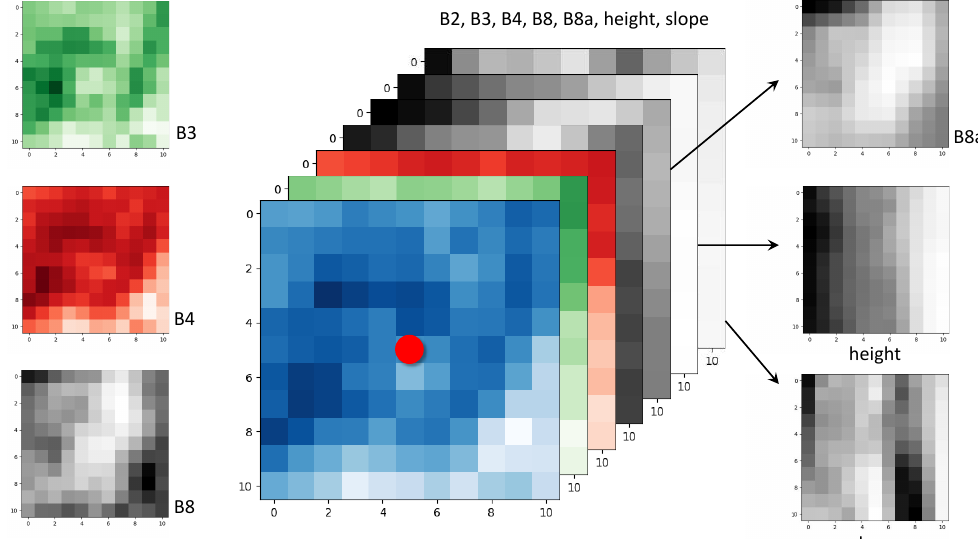
Figure 2. Reconstruction of a data point with erosion value 0 and coordinates (398,402.355, 439,987.376) and the 11 × 11 surrounding pixels that were classified with that erosion value. Bands 2, 3, 4 are the RGB layers, other bands are also shown, as well as height and slope